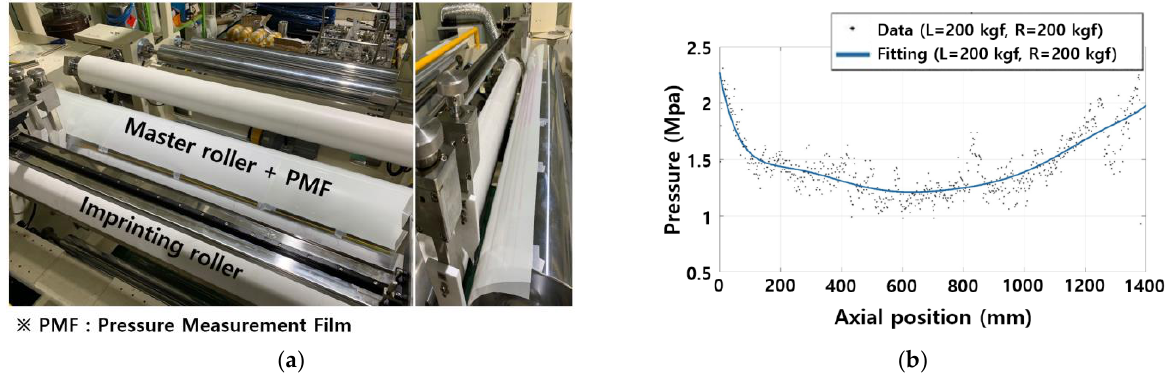
Figure 4. Imprinting module of conventional R2R NIL system used in experiments: ( a ) Setup of pressure measurement film on conventional R2R NIL system for experiments; ( b ) Pressure distribution along